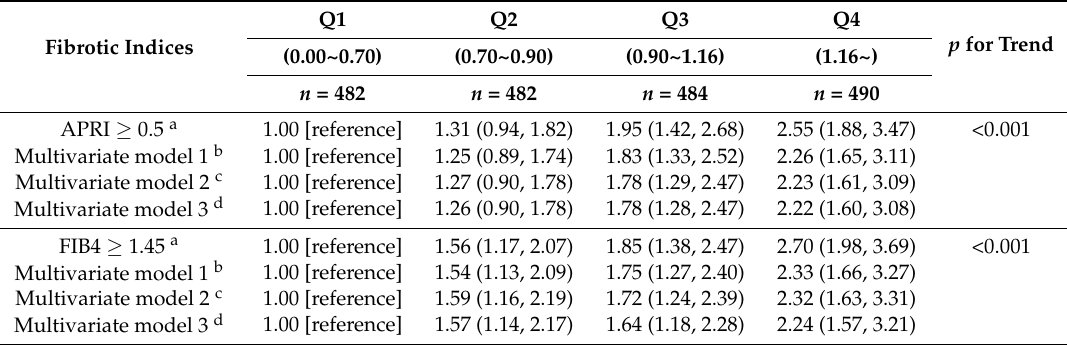
Table 3. Odds ratios and 95% CIs for serum TBil levels and the presence of elevated levels of APRI or FIB-4 in HBsAg (+)